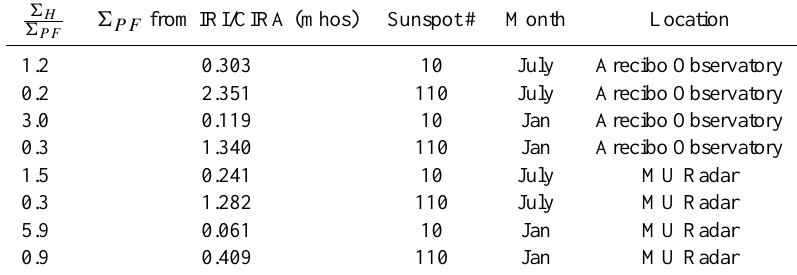
Figure 6: E layer evolution on a long time scale under the non-resonant condition, for a 200 km wavelength initial seed s Table 2. 6 H /6 PF ratio computed from IRI/CIRA models for the F layer conductivity, at 23:00 LT, and an E s layer based on Miller and (a), and for a 100 km wavelength initial seed (b). The boundary conditions are periodic in the horizontal direction. The Smith (1978). axes are described in the first paragraph of Section 4, and summarized in Figure 3.